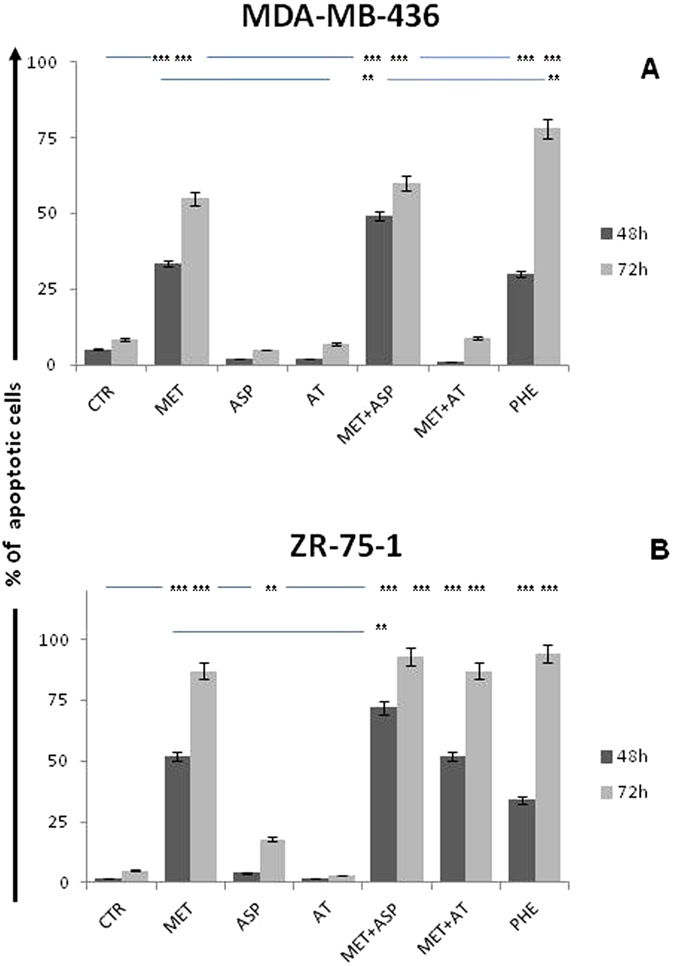
Induction of BC cells apoptosis in vitro in culture with Met, Asp, At and Phe.Panels (A,B) show the effect of Met, Asp and At on MDA-MB-436 and ZR-75-1 cells, respectively. Cell apoptosis was analyzed by flow cytometry, and shown as percent viable cells. The addition of Asp to Met significantly increased the frequency of apoptotic BCs. *P < 0.05, **P < 0.01, ***P > 0.005 vs controls or Met alone.